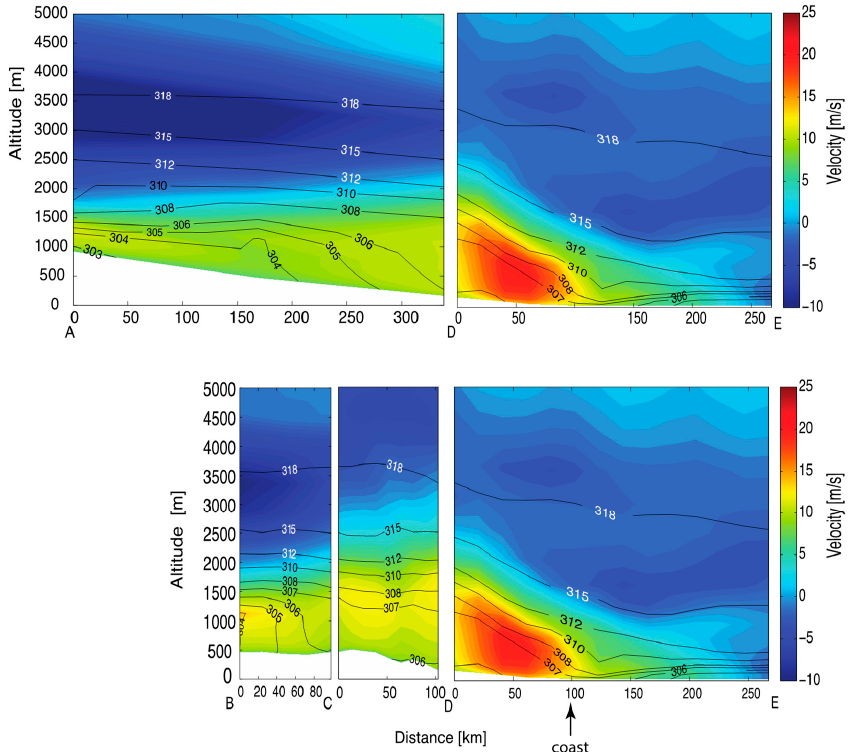
Figure 5. Longitudinal sections of potential temperature (black contours) and the along-section velocity component (colors) beginning in eastern (top) and western (bottom) spillways, ADE and BCDE respectively. The orientation of the section line is constant within each panel but changes between panels: thus, the along-section velocity component is discontinuous. The data are plotted at 05 UTC on 12 July 2008 and the section locations are shown in Figure 1.